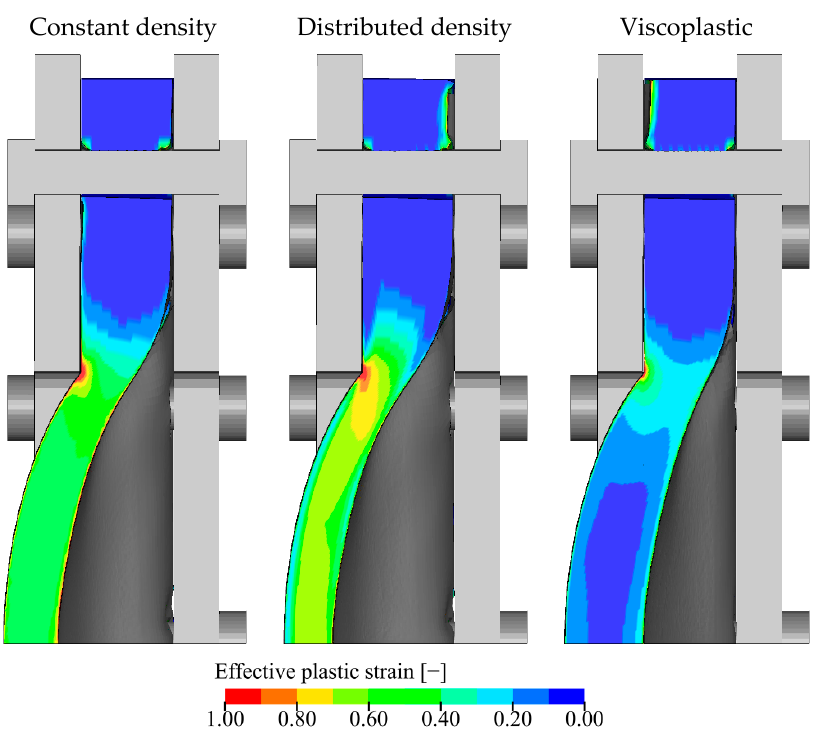
Figure A13. Deformation profiles and plastic strain from numerical simulations of test Sw_250_P15.